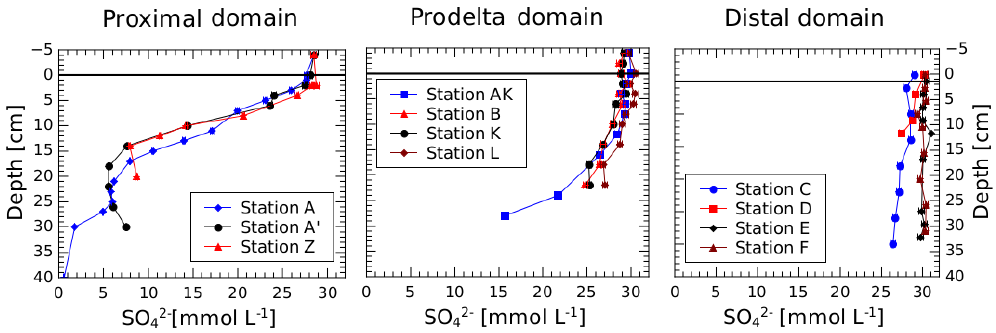
Figure 8. Sulfate profiles measured in the porewaters (mmolL − 1 ) of the proximal, the prodelta and in the distal domains.